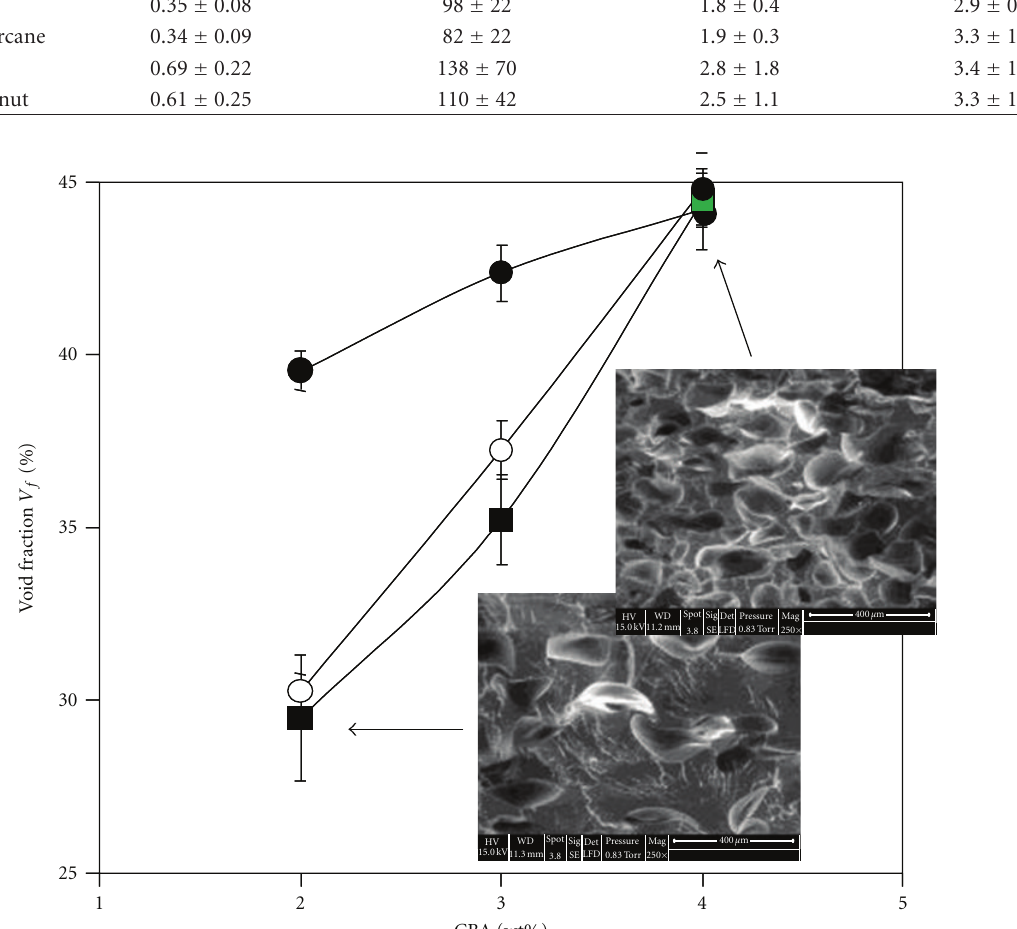
Figure 5: Void fraction of PLA foams as a function of the chemical blowing agent content (CBA1), the processing conditions (temperature profile: (cid:2) A; (cid:2) , (cid:3) B) and the PLA nature ( (cid:3) PLA4032D; (cid:2) , (cid:2) PLA7000D) and corresponding microstructures (ESEM observations; magnitude